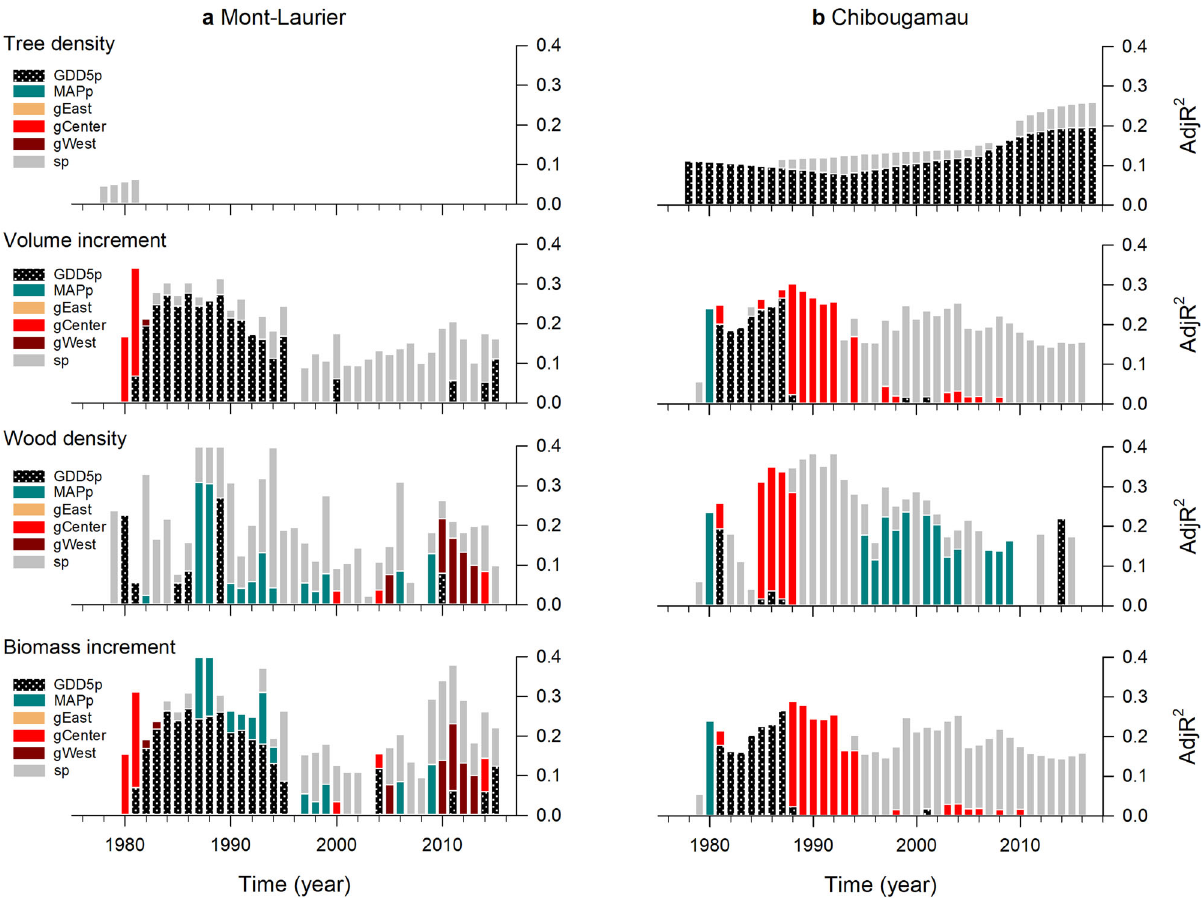
Fig. 6 Results of generalized additive models (GAM) for population differentiation and clinal variation in single traits. Illustrated are plot tree density ( n living trees per plot), tree annual volume increment, tree annual wood density, and tree annual biomass increment. The number of sampled independent populations in the analysis was n = 42 for Mont-Laurier and n = 45 for Chibougamau, each having three replicates. All shown variables are signi fi cant at the two-sided 5% level. See Fig. 2 for de fi